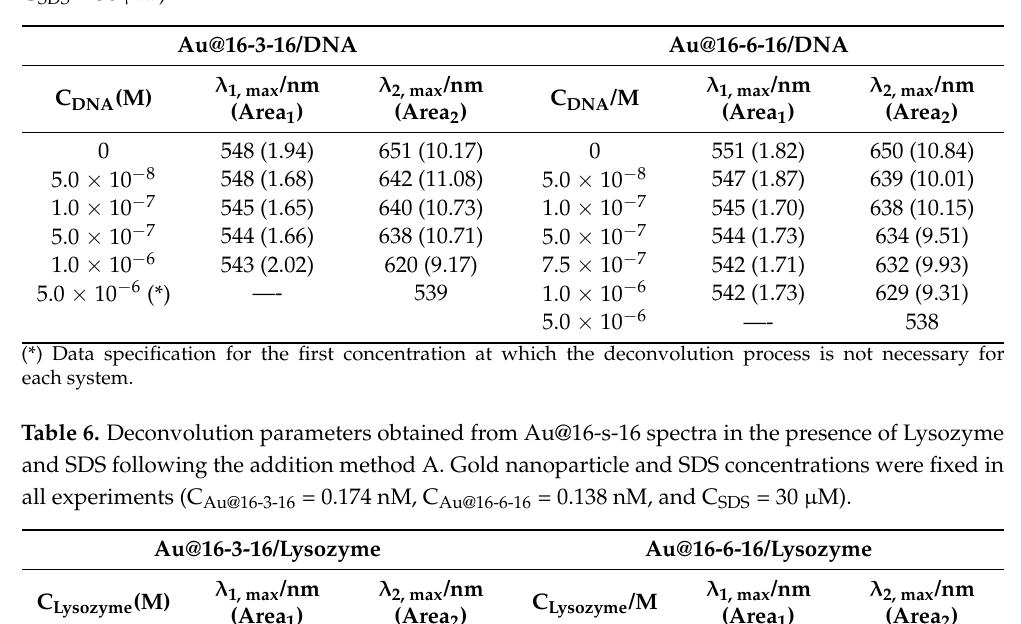
Table 5. Deconvolution parameters obtained from Au@16-s-16 spectra in the presence of DNA and SDS following the addition method B (Au@16-s-16 + DNA + SDS). Gold nanoparticle and SDS concentrations were fixed in all experiments (C Au@16-3-16 = 0.174 nM, C Au@16-6-16 = 0.138 nM, and C SDS = 30 µ M).